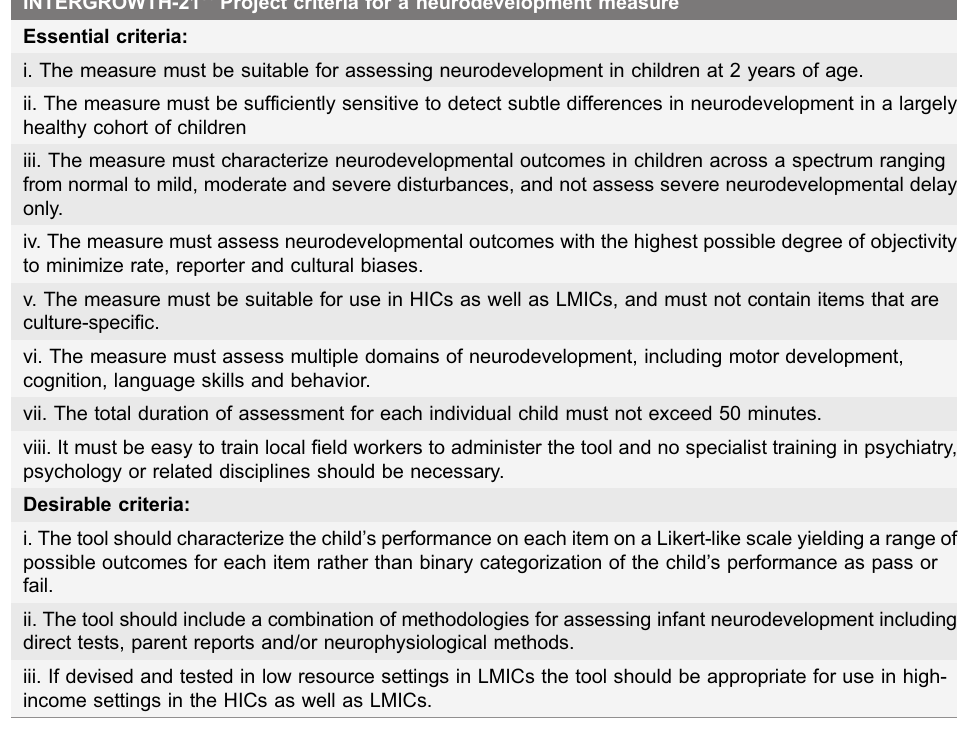
Table 3. Criteria to be met by a neurodevelopment measure for inclusion in the INTERGROWTH-21 st Project. INTERGROWTH-21 st Project criteria for a neurodevelopment measure Essential criteria: